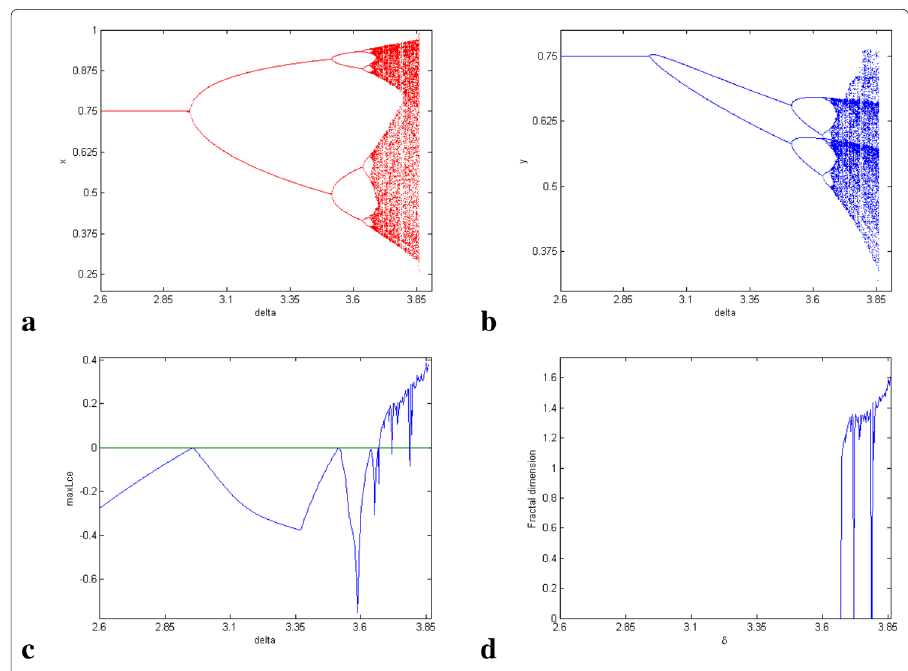
Fig. 1 Flip bifurcation of system (3). a Bifurcation in prey. b Bifurcation in predator. c Maximum Lyapunov exponents related to a , b . d FD corresponding to a . ( x 0 , y 0 ) = ( 0.74,0.74